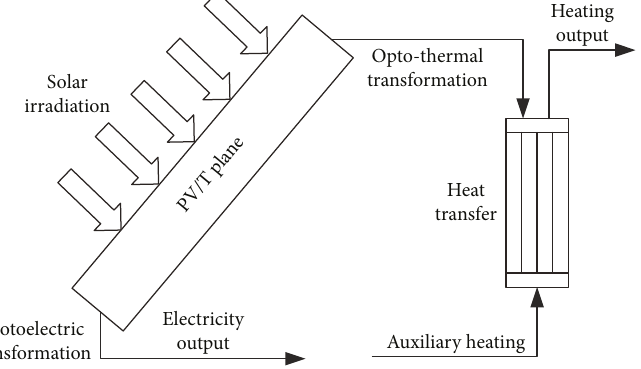
Figure 7: The schematic of the PV/T system.